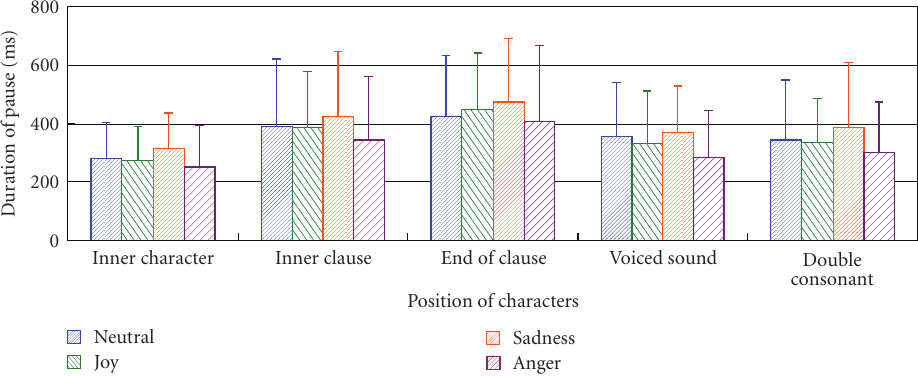
Figure 21: Mean of duration of pause as a function of emotions and position of characters (error bars represent standard